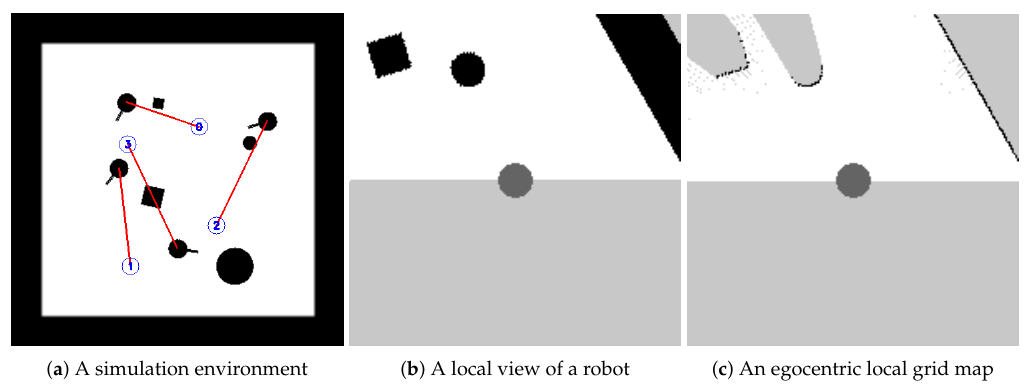
Figure 1. ( a ) A training environment of the simulator, where blue digital circles represent the target positions of robots with the corresponding number, red lines specify the straight paths from the current position to the target for robots and other black pixels represent various obstacles. ( b ) The local view of the environment for the robot 0. ( c ) The egocentric local grid map generated from the local view using a 2D laser